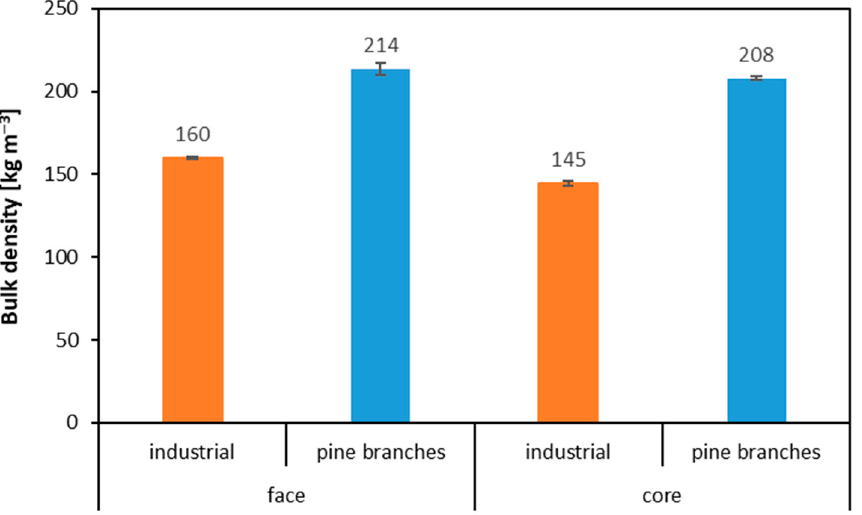
Figure 4. Bulk density of particles from pine branches used in the manufacture of three-layer parti- cleboard.